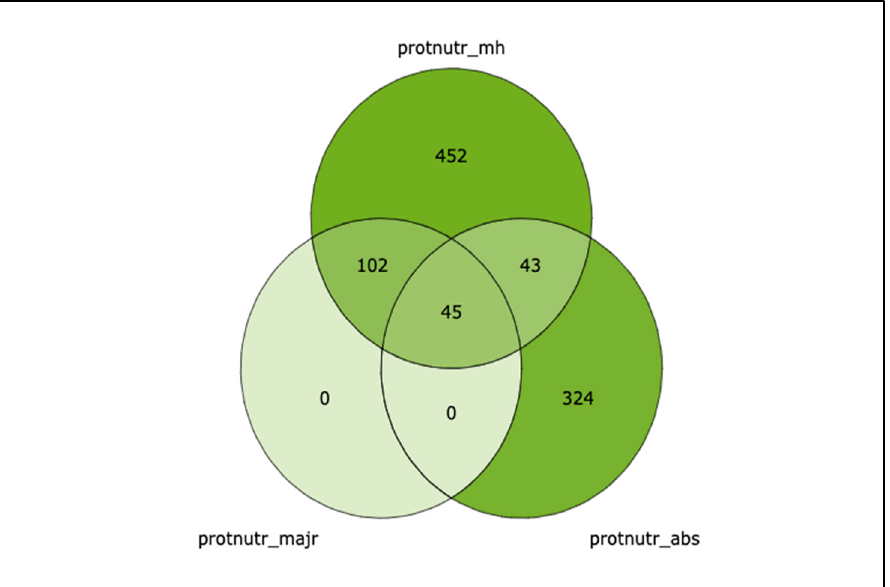
Figure 1. Venn diagram of unique abstracts with overlaps queries of nutrition proteomics. An interactive version of this figure with links to the PubMed abstracts is in the File SA.